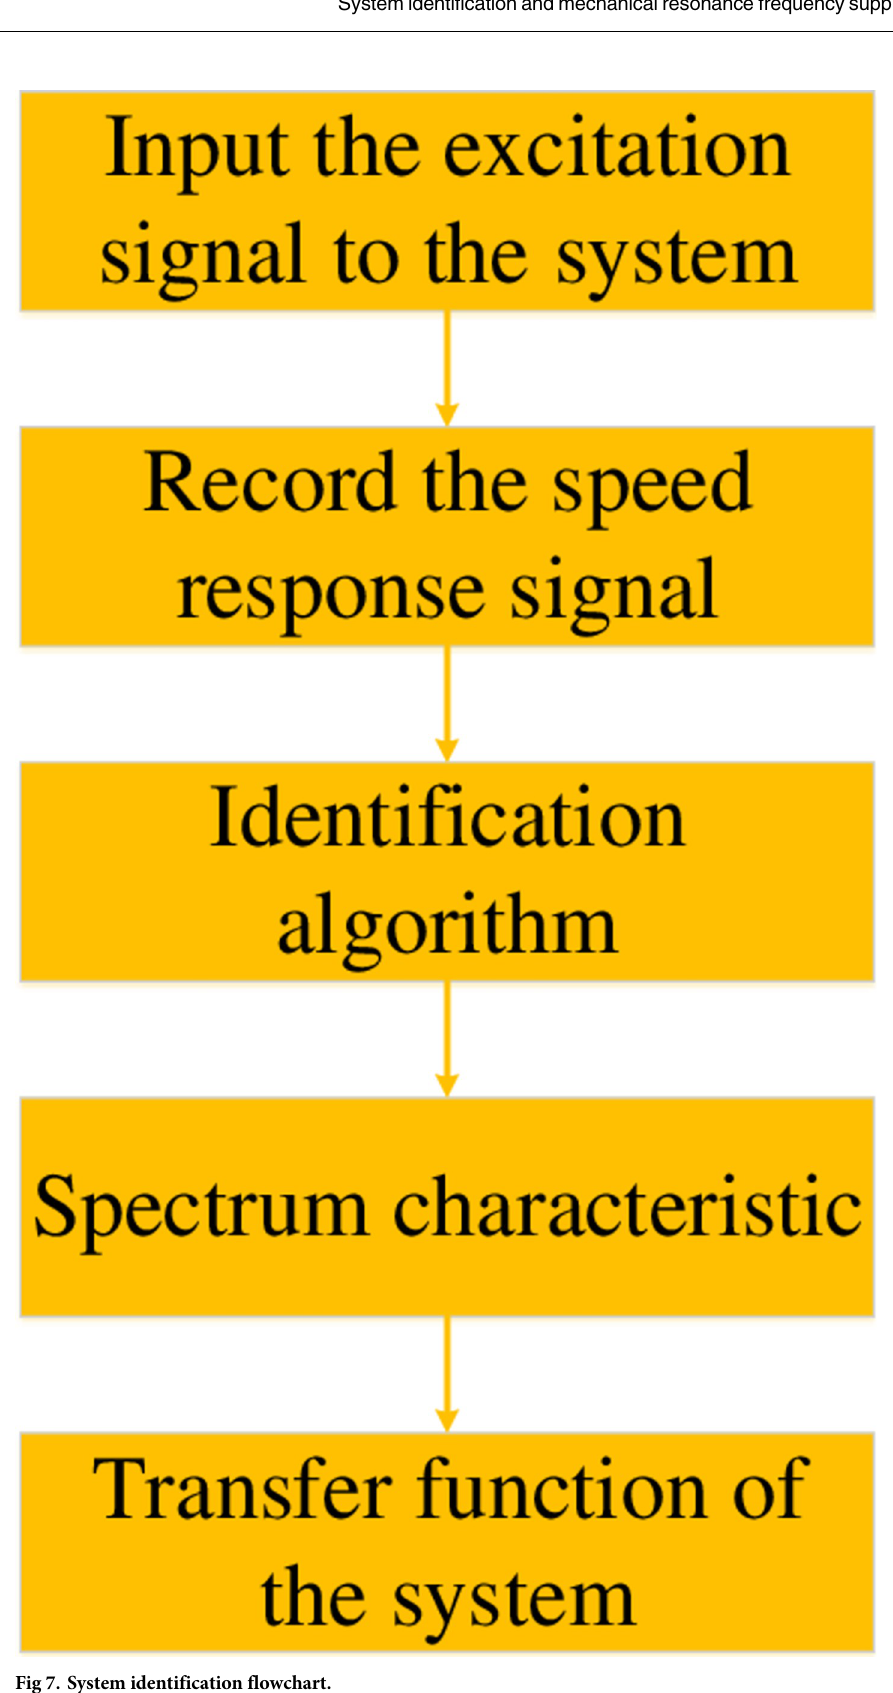
Fig 7. System identification